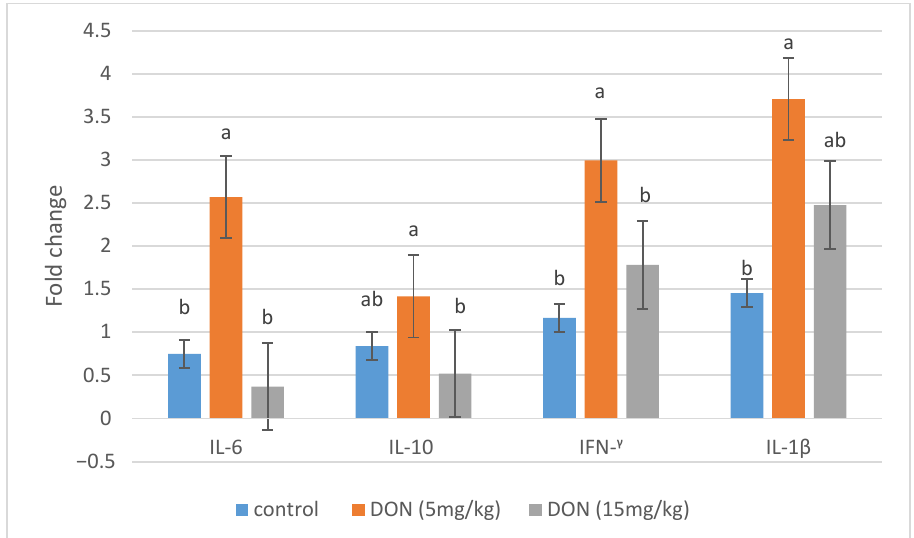
Figure 2. Effects of DON-contaminated feed (5 and 15 mg/kg) on the relative mRNA expression of immune genes (IL-6, IL-10, IFN- ᵞ , and IL-1β) in the jejunal tissues of broiler chickens determined by qRT-PCR. Bars show the means and the standard error of means (SEM) ( n = 5); a,b : values with different superscripts for each cytokine differ ( p ≤ 0.05). Table 7. Effects of DON-contaminated feed (5 and 15 mg/kg) on the H/L ratio and plasma corticosterone level of broiler